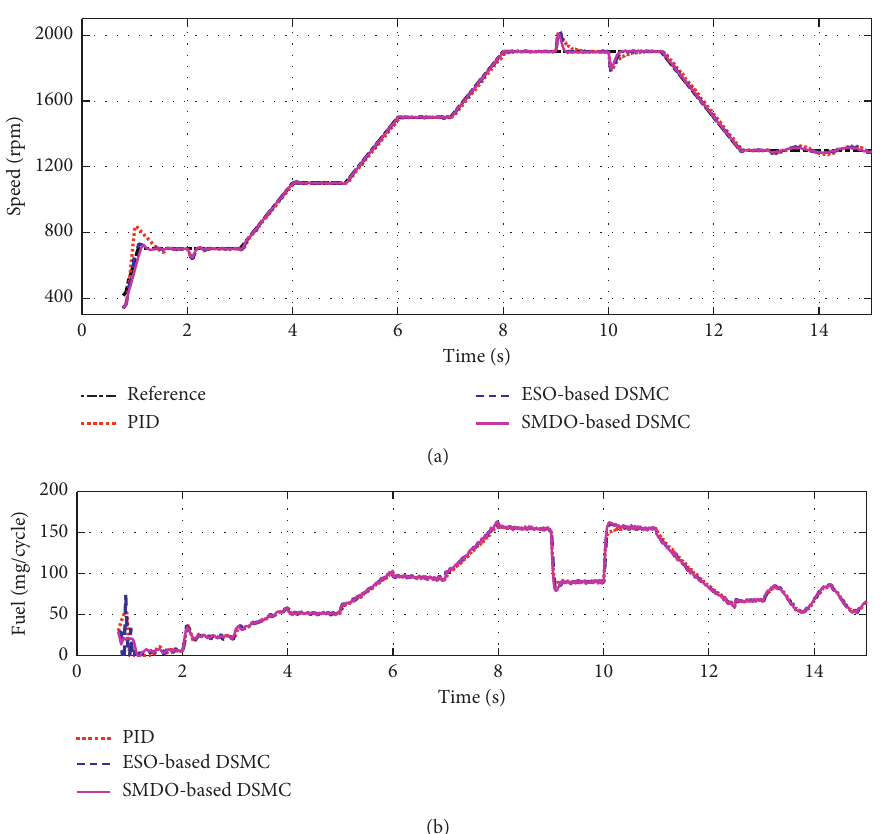
Figure 8: The control performance comparison between the PID controller, the ESO-based DSMC, and the SMDO-based